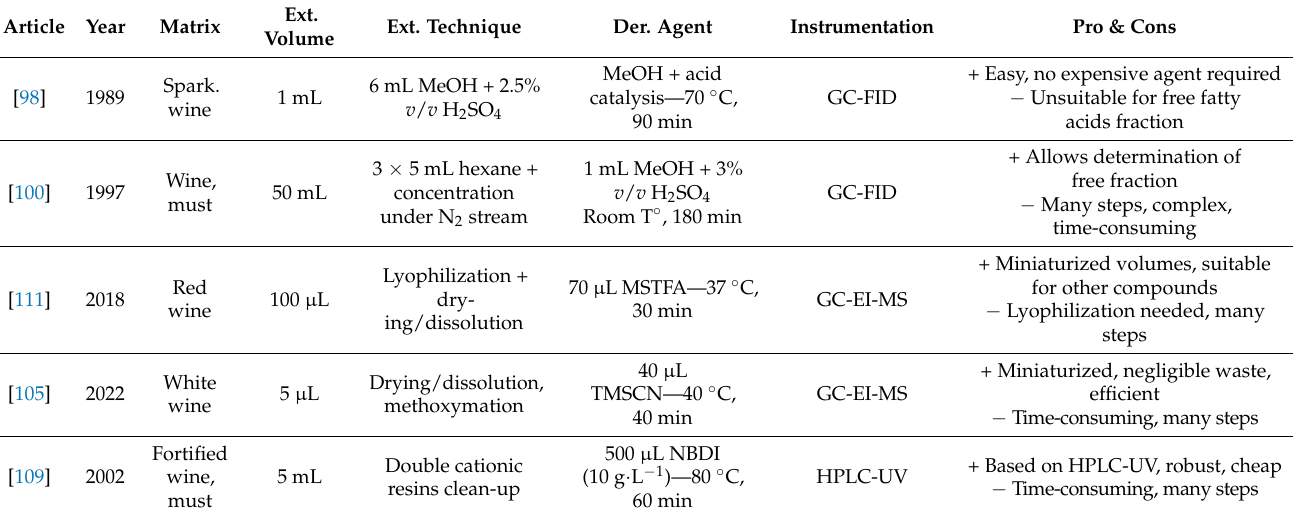
Table 3. GC-MS and LC-MS methods presented for carboxylic acid determination and related high- lights.